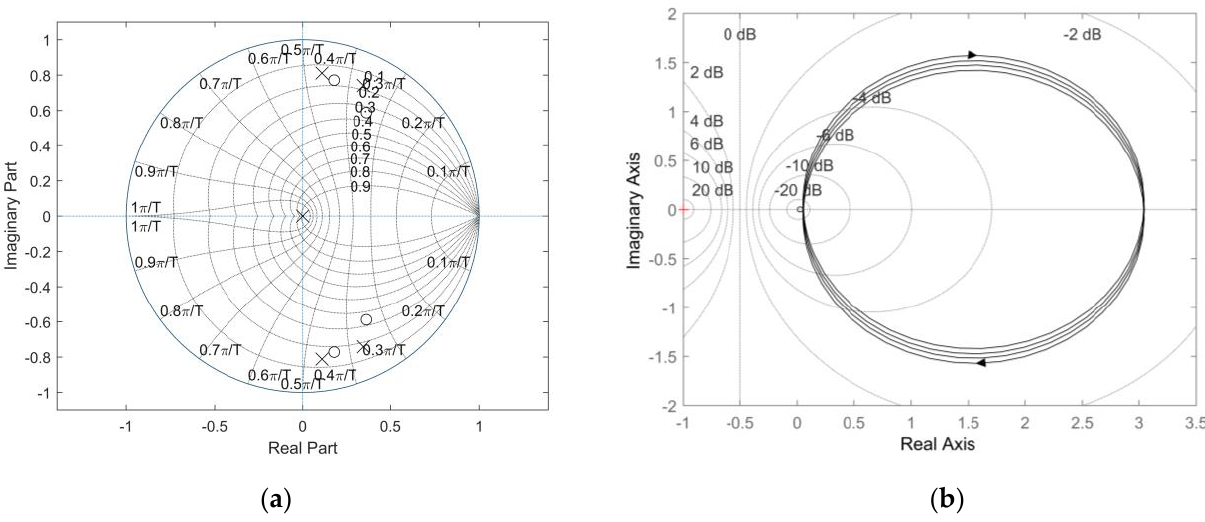
Figure 7. Pole-zero and Nyquist diagram: ( a ) Pole-zero diagram; ( b ) Nyquist diagram.